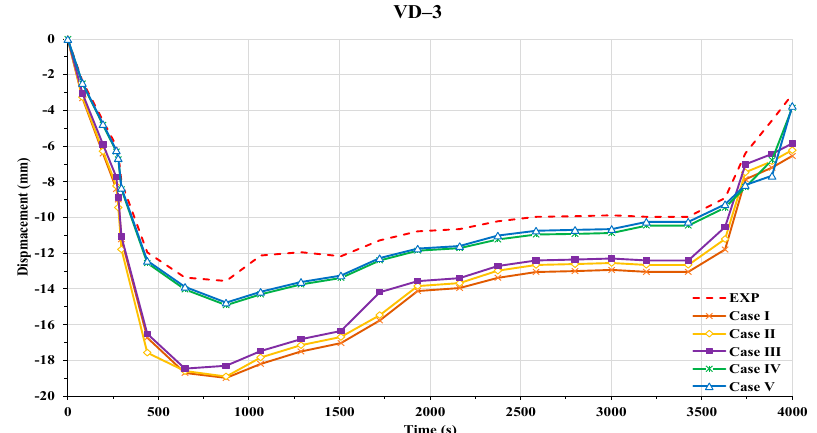
Figure 21. Displacement over time at VD-2.